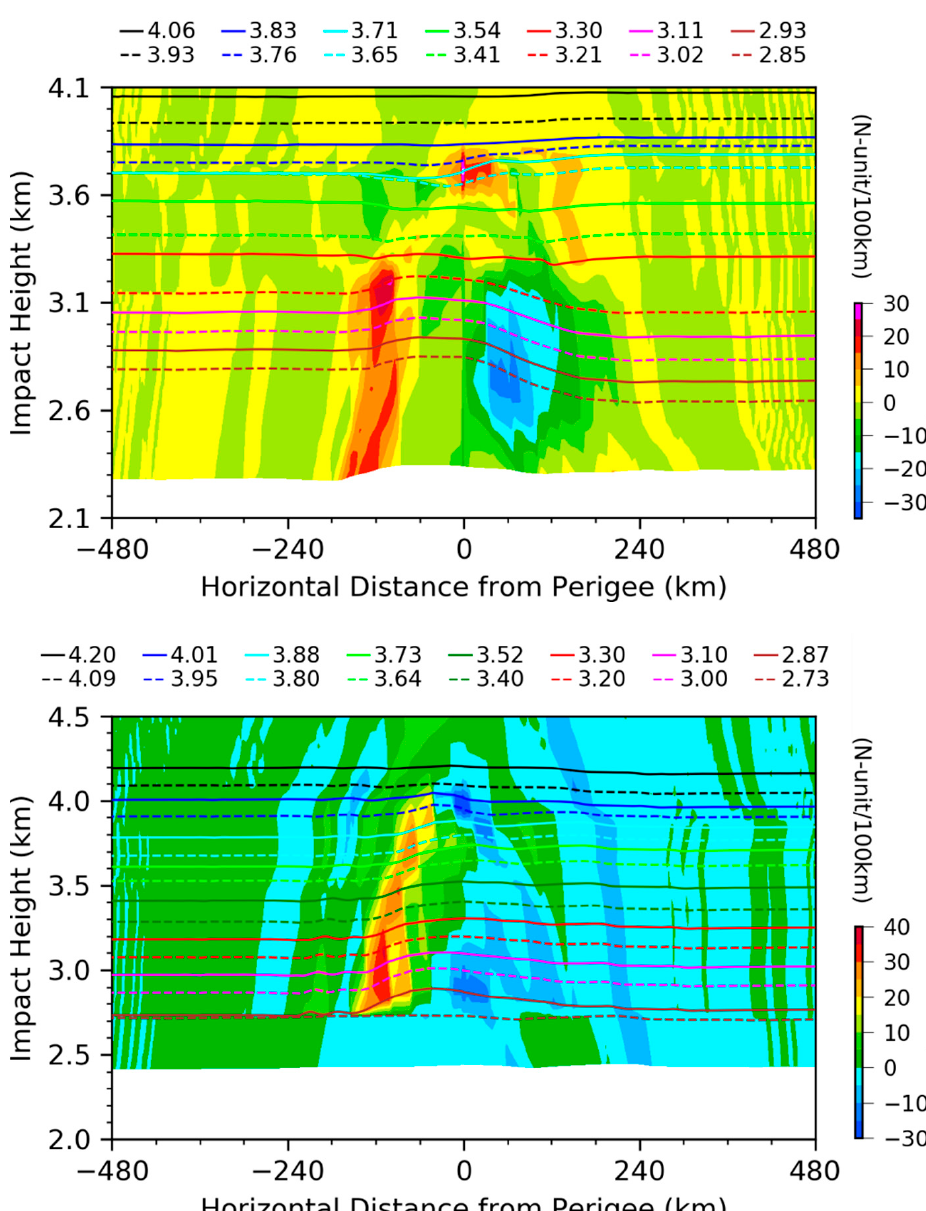
Figure 6. Same as Figure 5 except the background colors show the horizontal gradient of N wet ( N -unit. (100 km) − 1 ).